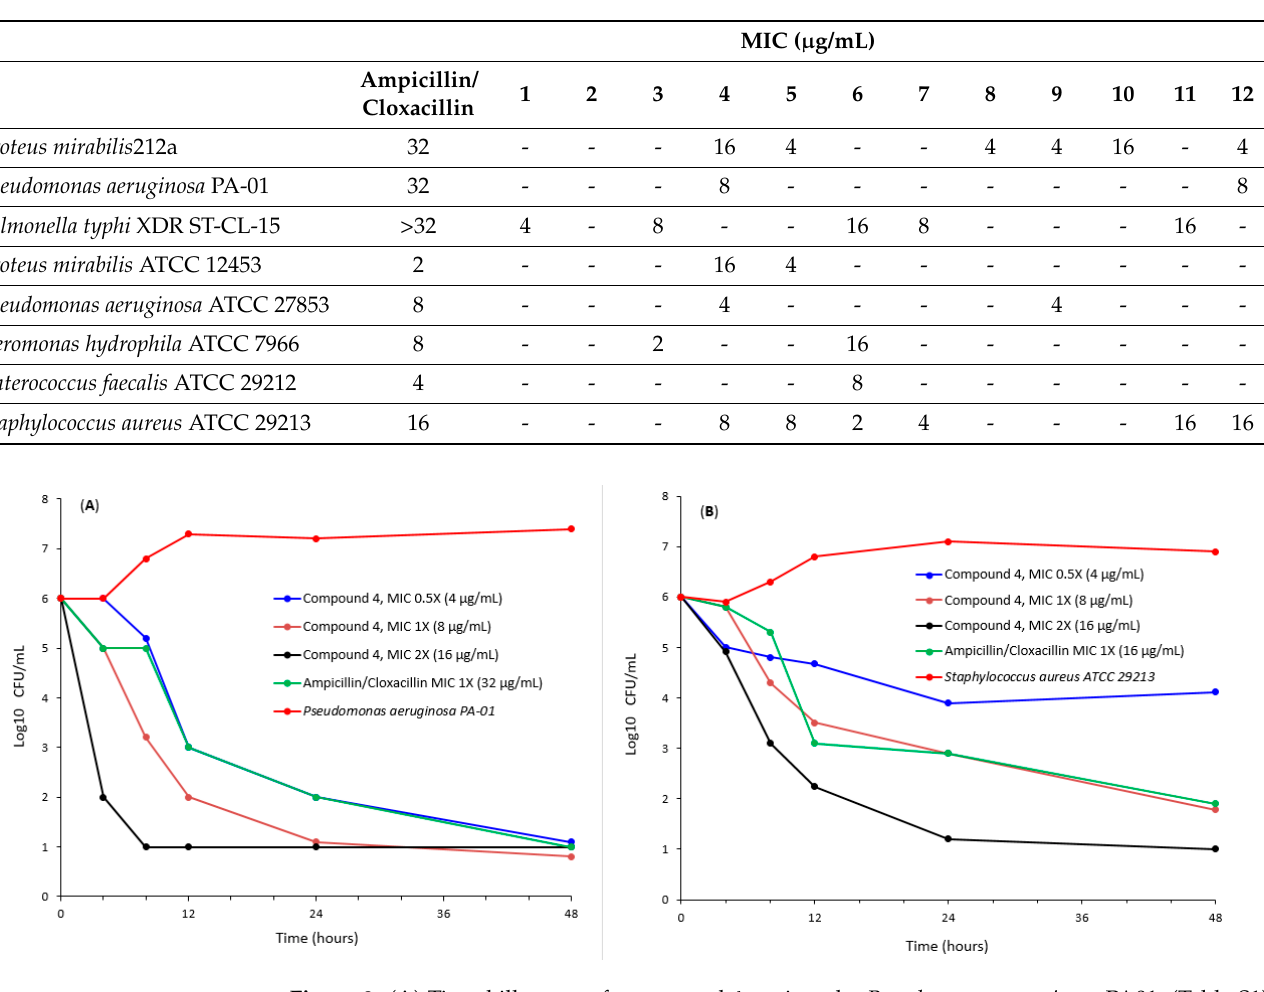
Figure 8 . ( A ) Time-kill curve of compound 4 against the Pseudomonas aeruginosa PA01, (Table S1); ( B ) Staphylococcus aureus ATCC 29213, (Tabel S2) .